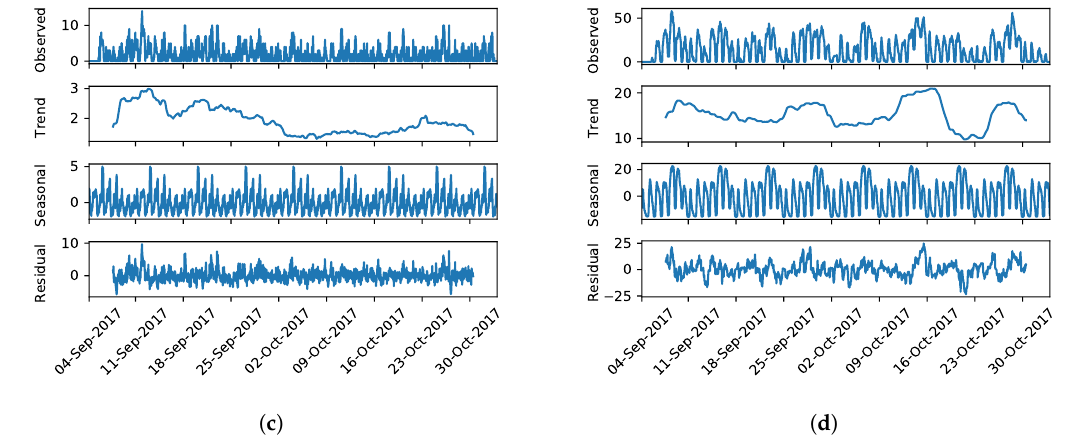
Figure 10. Observed occupation levels and seasonal decomposition of representative cells. ( a ) cell business; ( b ) cell catering and entertainment; ( c ) cell mixed functional area; ( d ) cell transport